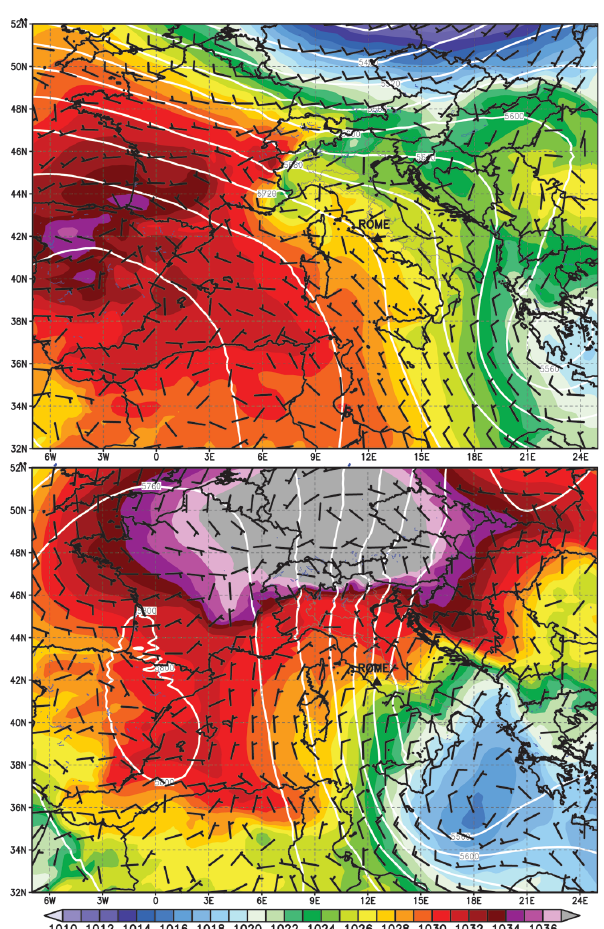
Fig. 2. Synoptic maps from ECMWF analyses at 0.25 ◦ of resolu- tion for (a) 6 February 2008 at 12:00UTC and (b) 7 February 2008 at 18:00UTC. Colors represent the mean sea level pressure (hPa), white lines the geopotential height at 500hPa (m), and black vectors the horizontal speed at 10m (ms − 1